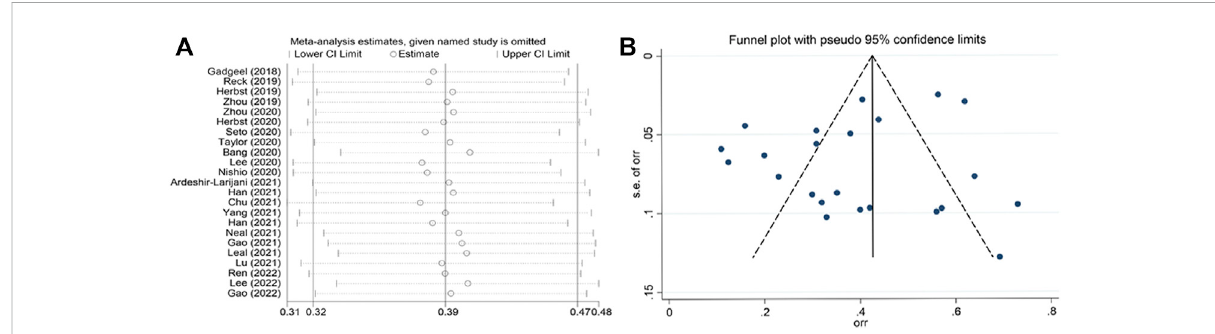
FIGURE 4 Sensitivity analyses (A) and funnel plot (B) of the ORR among the included